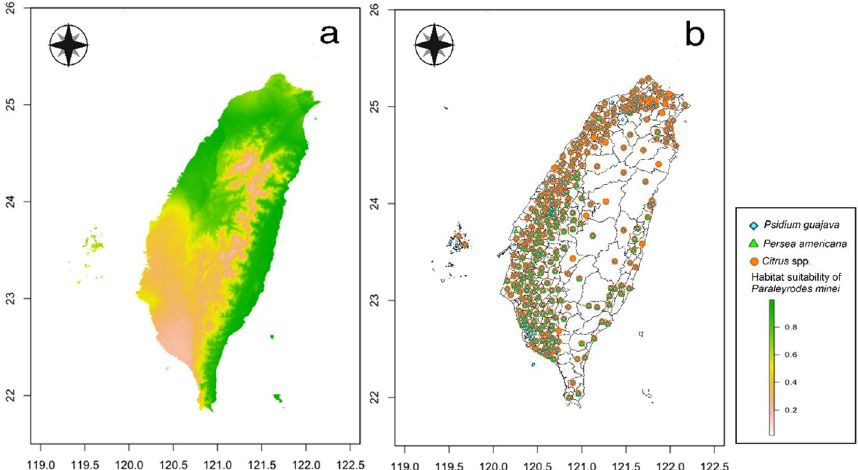
Figure 6. Comparison of potential distribution area of Paraleyrodes minei and cultivation areas of Psidium guajava , Persea americana , in Taiwan: ( a ) potential distribution ( b ) cultivation areas. Maps were created using R version 4.04 (https:// www.r- proje ct. org/) and QGIS version 3.12.1 (www. qgis. org).